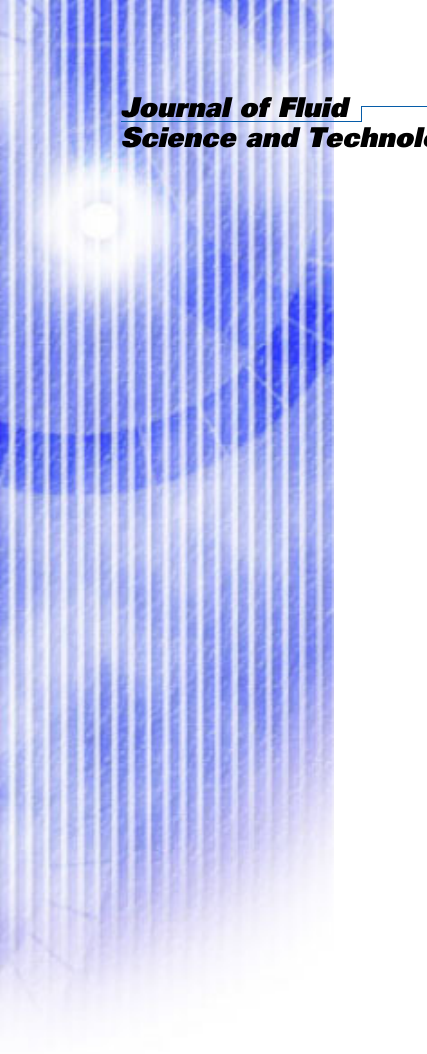
Fig. 12 Ensemble-averaged time histories of conditionally sampled velocity and wall static pressure at higher modes ( n = 4 ∼ 23) corresponding to the bulge structure